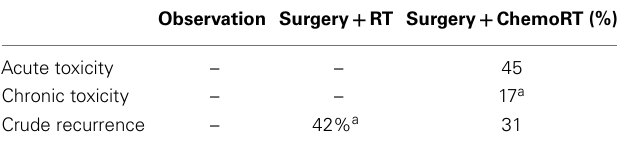
Table 3 | Outcome summary of prospective